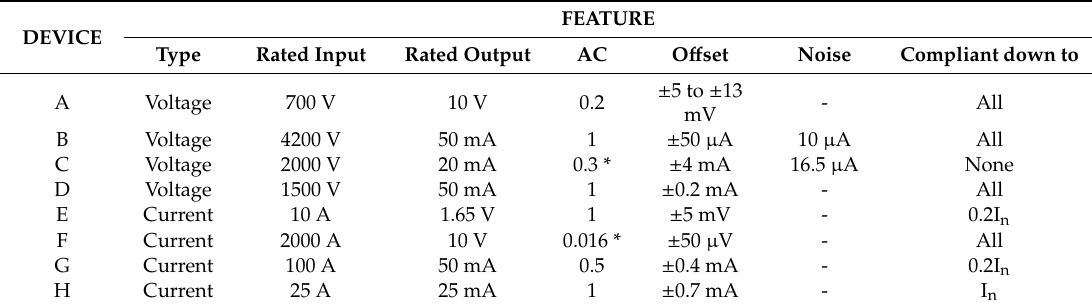
Table 7. Electronic Instrument Transformer (EIT) features collected from o ff -the-shelf devices of di ff erent